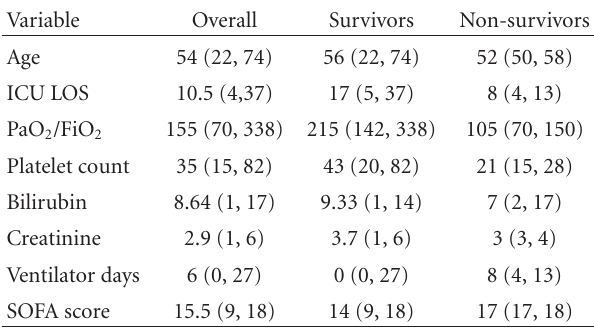
Table 1: Demographic and Clinical Data on ICU admission in sur- vivors and